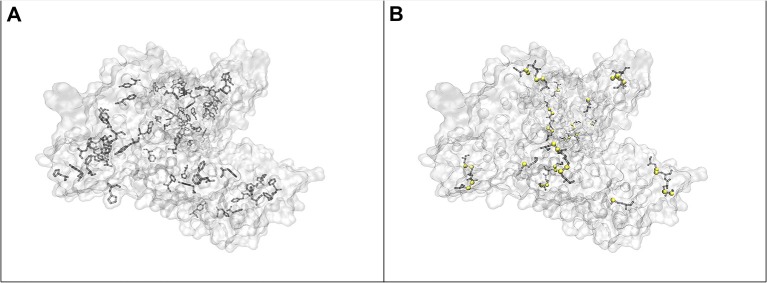
(A) Location of the aromatic side chains in BSA, (B) location of cysteine and methionine residues in the structure of BSA. (Humphrey et al., 1996; Bujacz et al., 2014) Sulfur atoms are marked with yellow spheres.